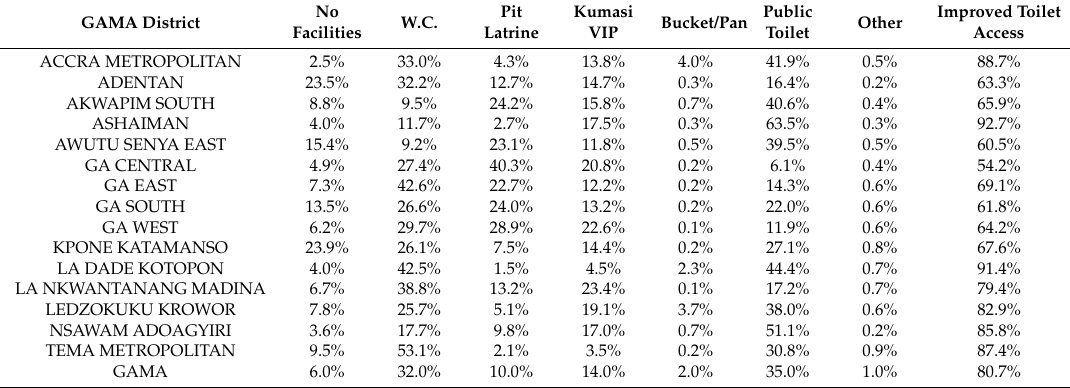
Table notes: Improved toilet access is the sum of water closet (W.C.), Kumasi VIP, and Public Toilets. W.C. is a flush toilet connected to a sewer or septic